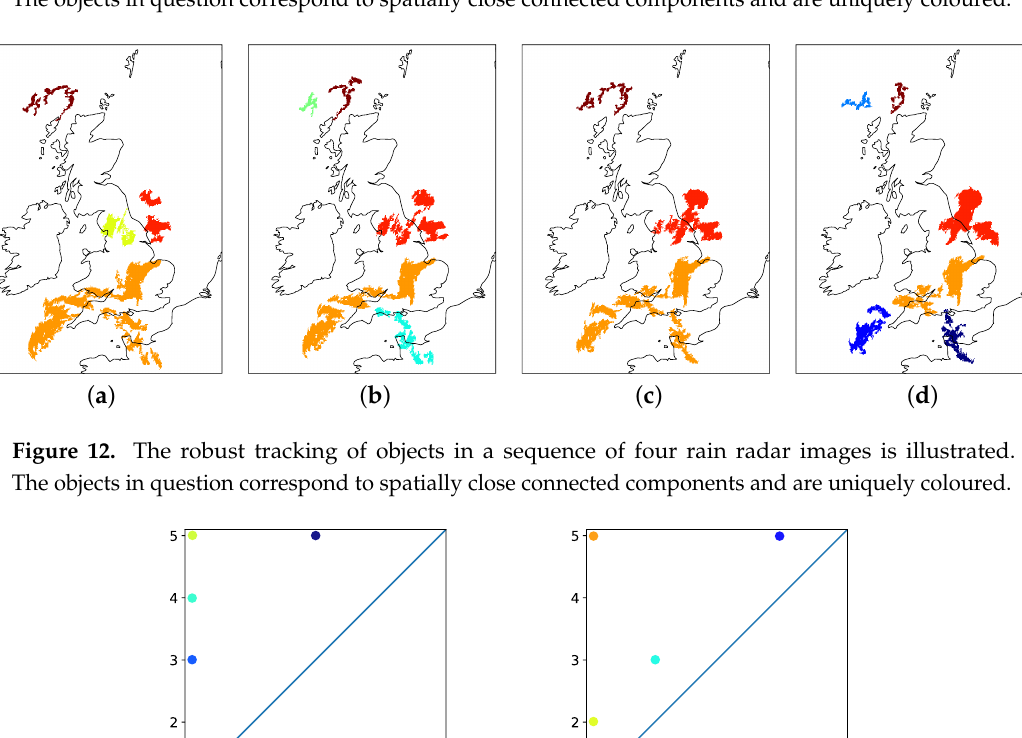
Figure 11. The robust tracking of objects in a sequence of four rain radar images is illustrated. The objects in question correspond to spatially close connected components and are uniquely coloured.